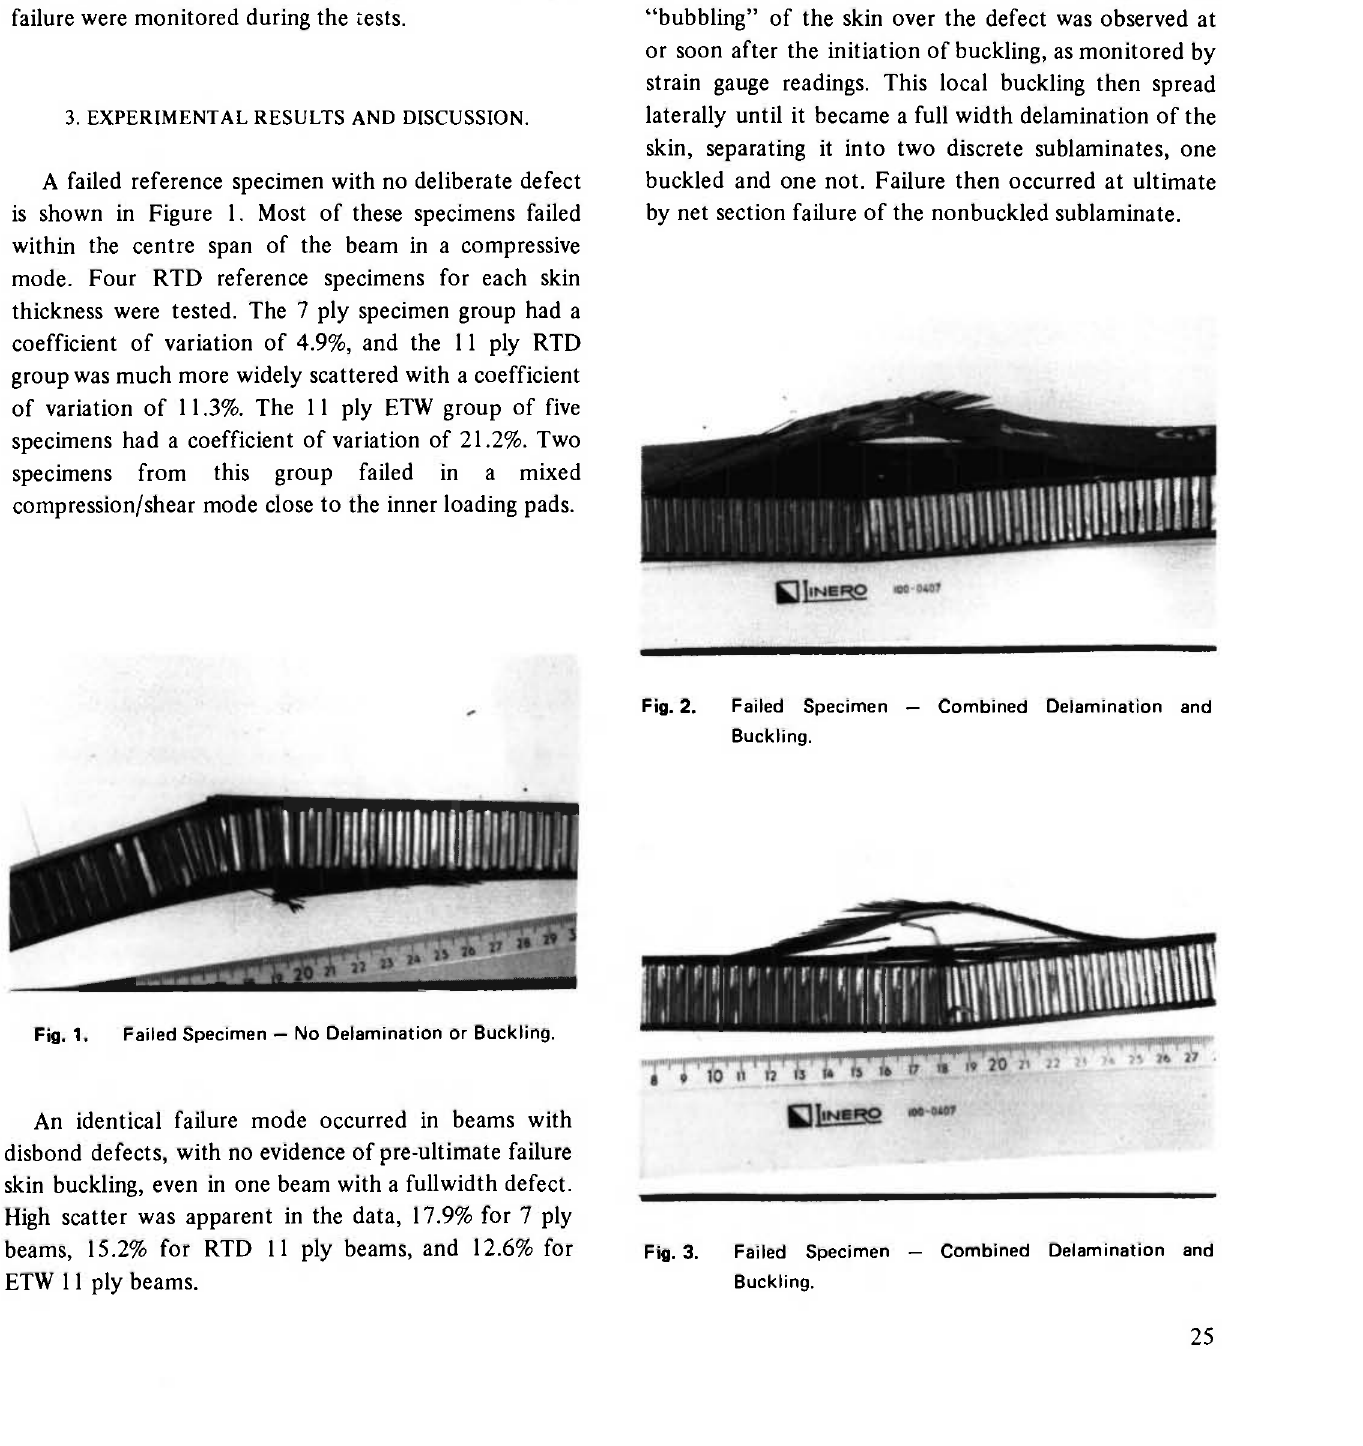
Fig. 3. Failed Specimen — Combined Delamination and